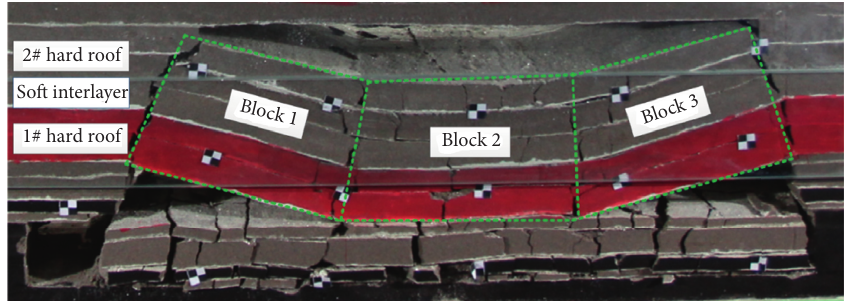
Figure 6: Face advance 162.4m.